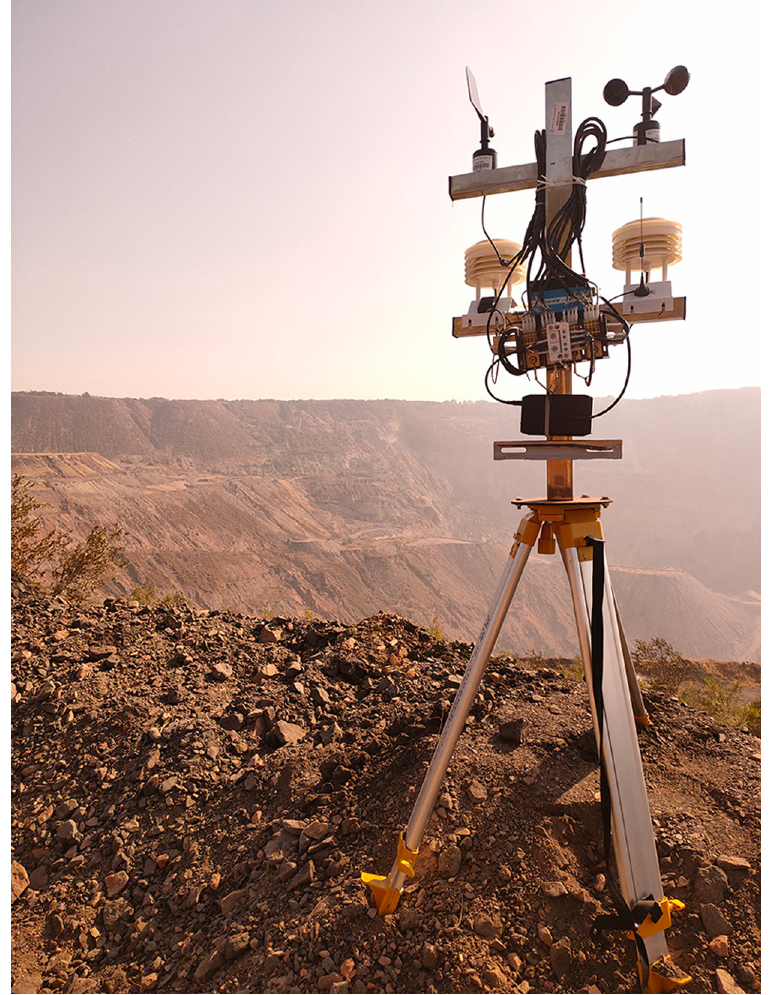
Fig 10. No. 5 monitoring point of transportation road of opencast coal mine.